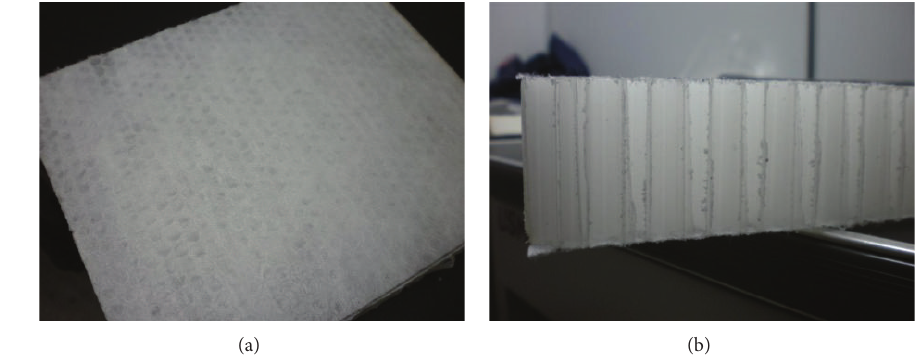
Figure 1: Polypropylene honeycomb core in (a) top view and (b) side view.